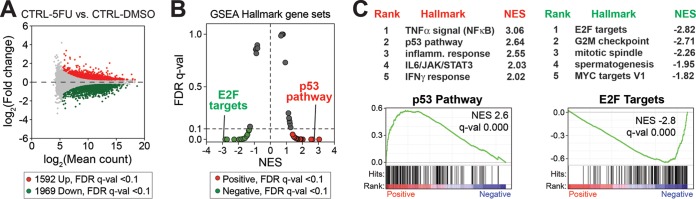
SJSA transcriptional response to 5-FU. (A) MA plot comparing RNA-Seq data from shCTRL SJSA cells after 5-FU treatment (versus DMSO control). (B) Plot of FDR versus the normalized enrichment score (NES) based upon GSEA from RNA-Seq data (shCTRL cells, 5-FU versus DMSO). The dashed line represents 0.1 FDR cutoff. As expected, stress response (e.g., p53 pathway) gene sets are enriched, whereas proliferative gene sets (e.g., G2/M checkpoint) are reduced in 5-FU treated cells. (C) Top five ranked positively and negatively enriched gene sets and GSEA plots for p53 pathway and E2F targets.